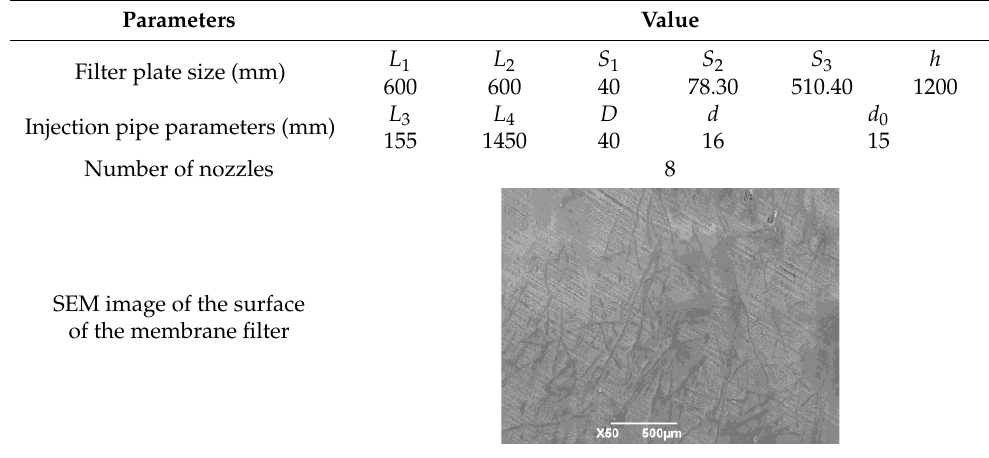
Figure 2. Model of the NSMMFP and injection pipe. ( a ) Three-dimensional map of the NSMMFP and injection pipe. ( b ) Physical picture of the NSMMFP. ( c ) Physical picture of injection pipe.